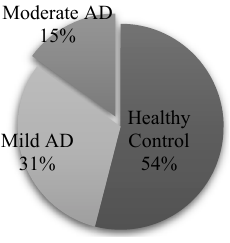
Figure 4. Distribution of the population by degree of AD.